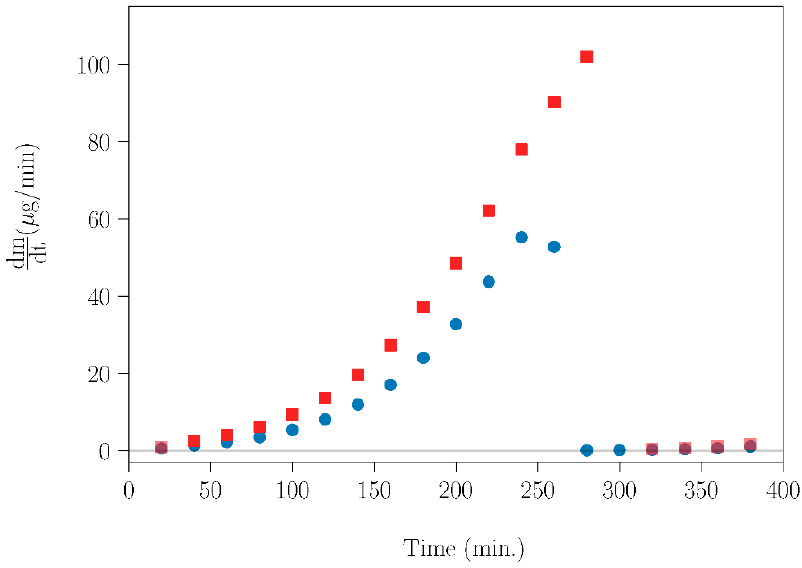
Figure 10. Evaporation rate (dm/dt) for S Lab (blue circles) and S Lab+T (red squares) over time. The measurements were carried out using an isothermal treatment for 20 min every 5